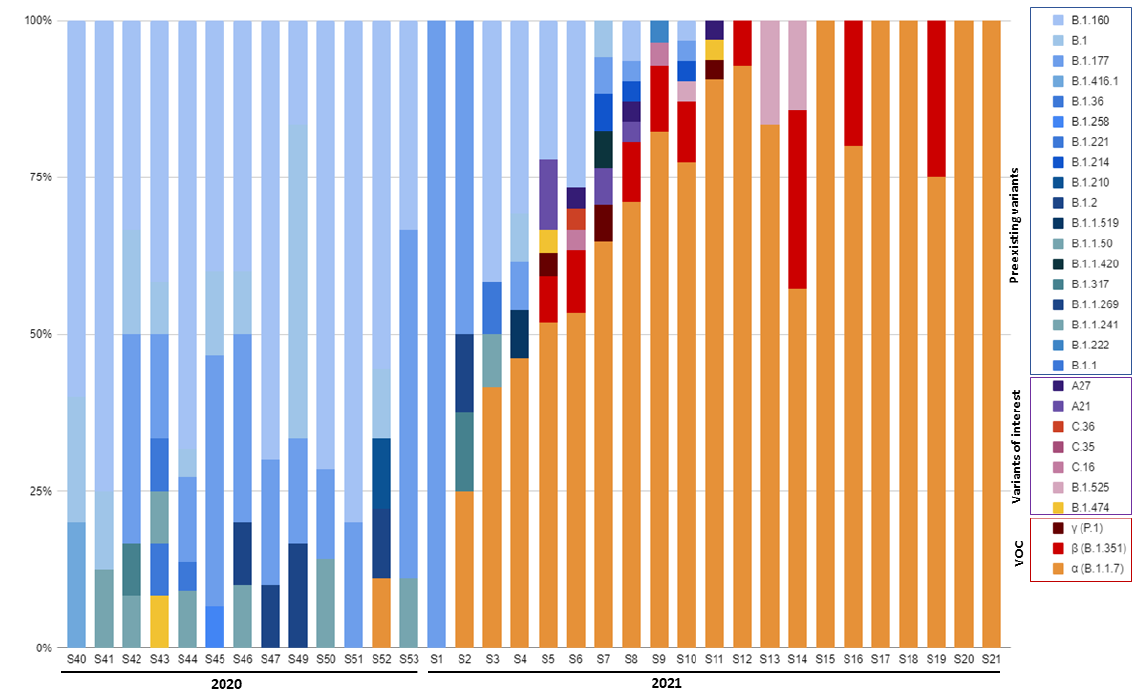
Figure 1. Time course of emerging SARS-CoV-2 variants during the study period. VOC, variants of concern.